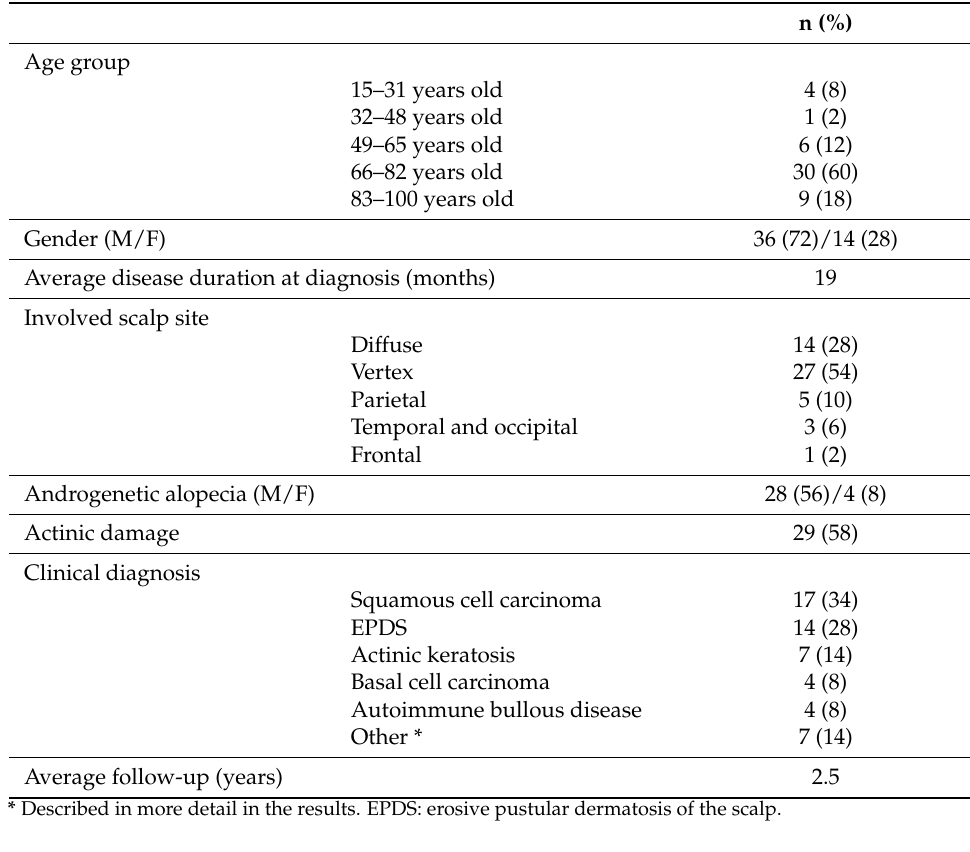
Table 2. Clinical data summary.